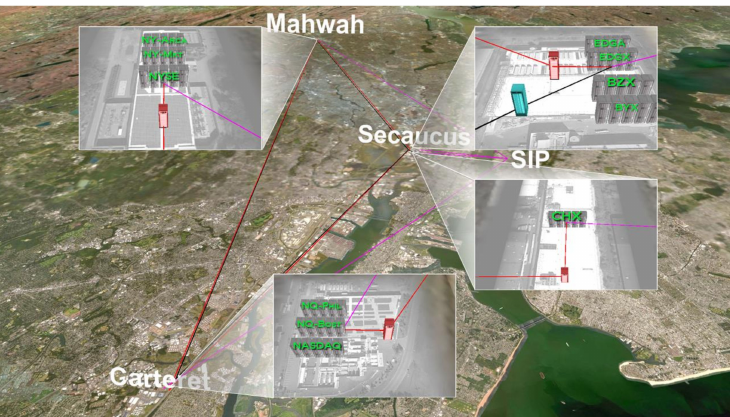
Figure 1. Graphical depiction of the three major market centers in the National Market System (NMS). SIP, Securities Information